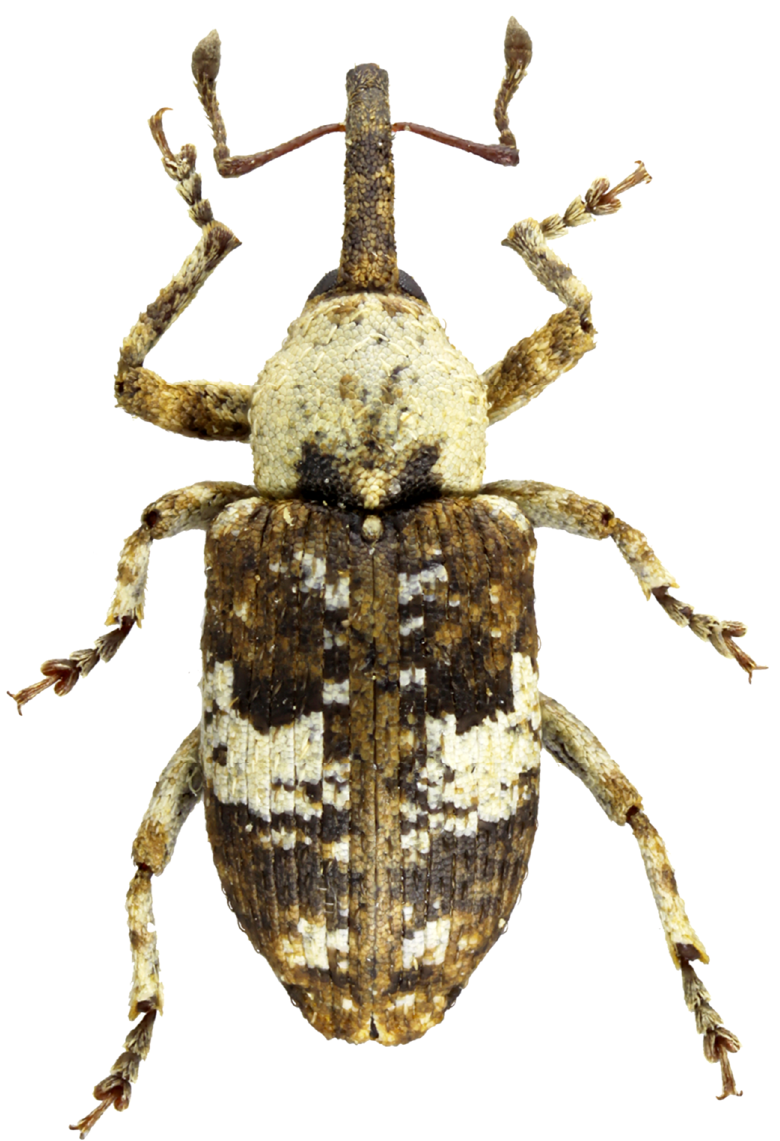
Figure 1. Acentrus histrio . Male. According to [2]. (Not to scale). Copyright confirmed by M. Jäch (Koleopterologische Rundschau), 30 April 2018.